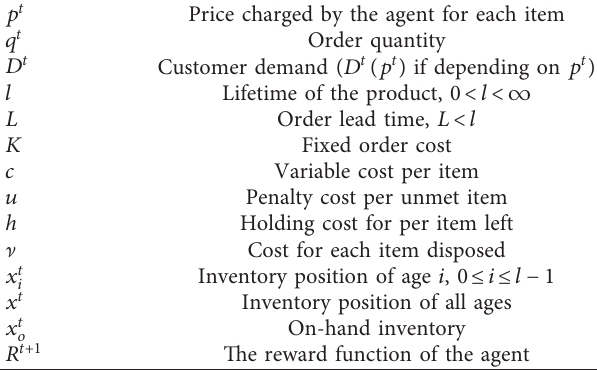
Table 1: Notations grouped by the elements of the RL problem. p t Price charged by the agent for each item q